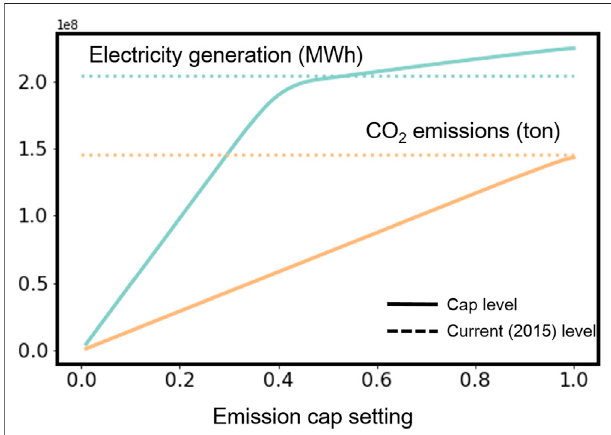
FIGURE 2 | Electricity generation and CO 2 emissions under different levels (1 – 100% of 2015 power plant emission level) of emission cap settings withmixedemissiontrading(ET)andcommand-and-control(CAC)policy.The cyan solid line indicates the maximum electricity generation under different CAC cap settings. The orange solid line indicates CO 2 emissions at the level of the CAC cap setting. The dot lines indicate the current levels (in 2015) of electricity generation and CO 2 emissions.